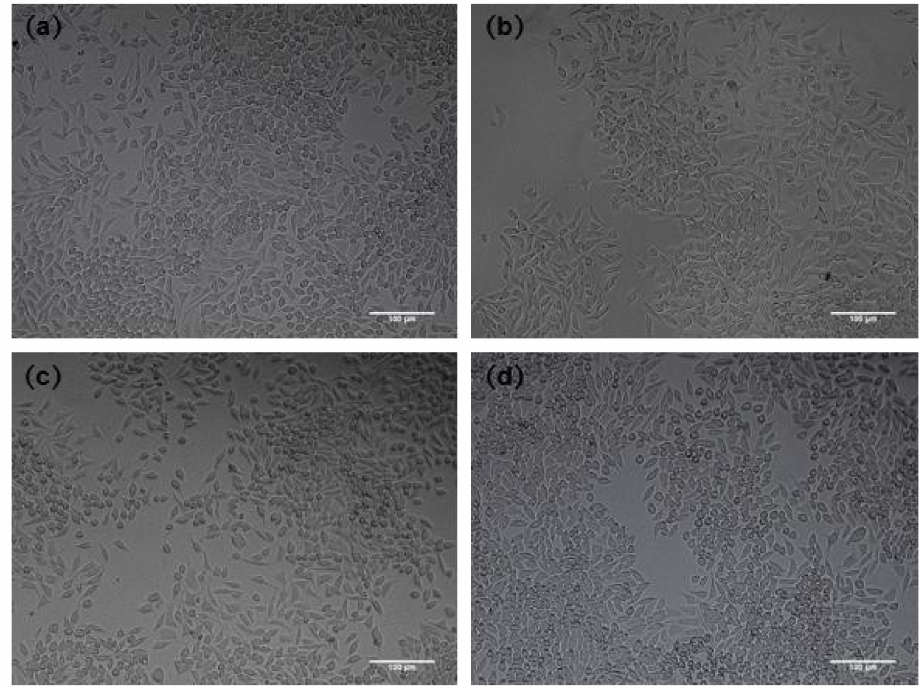
Figure 11. Inverted microscope images (10 × ) for the L-929 cells cultured with extracts originating from: ( a ) the negative group, ( b ) AZ31, ( c ) MgO-coated AZ31, and ( d ) ZrO 2 -coated AZ31 for 7